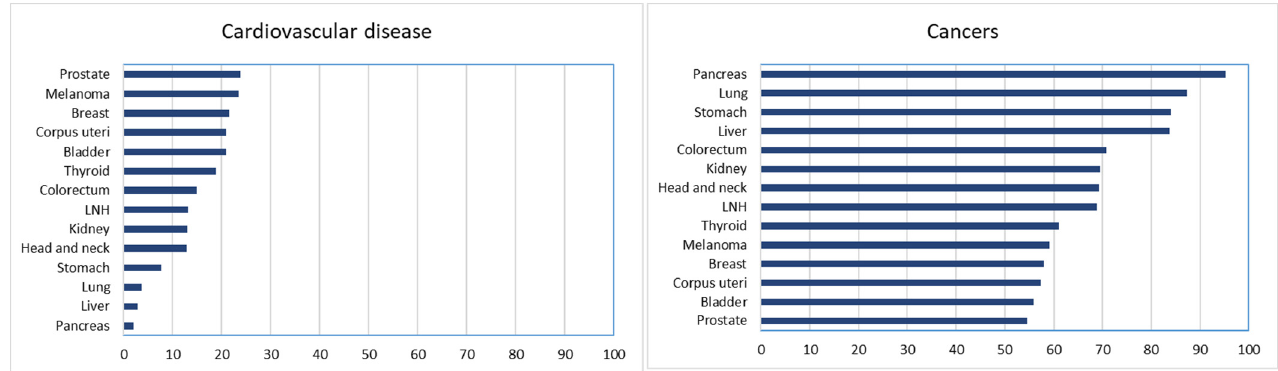
Figure 4. Percentage of deaths from cardiovascular disease and malignancy for 14 most important cancer sites. Reggio Emilia, Italy 1996–2019.